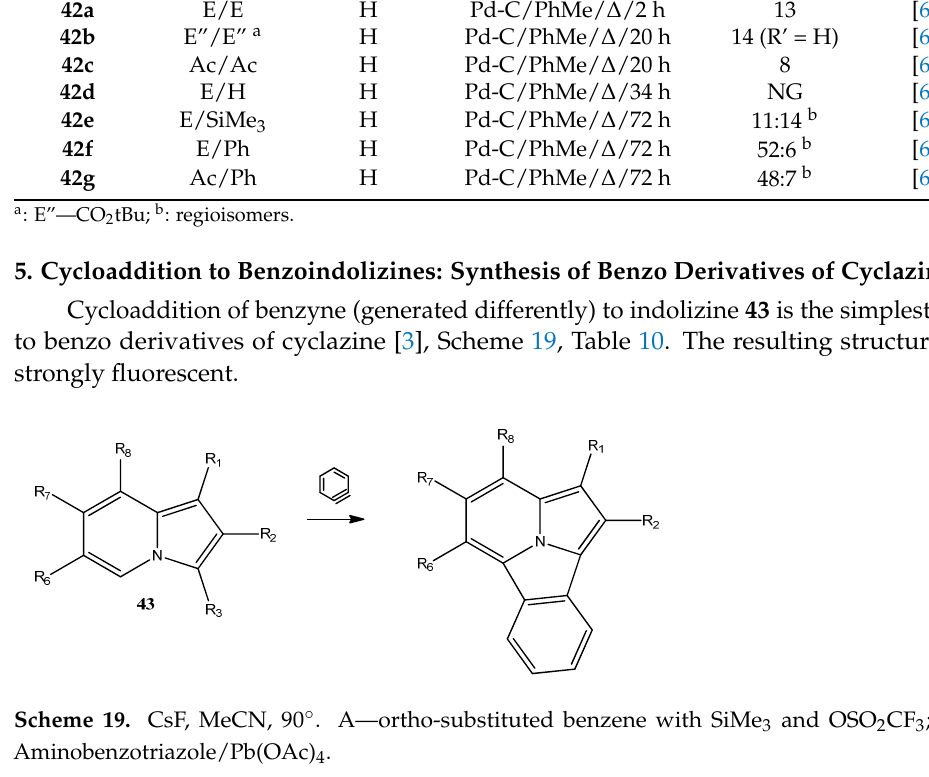
Table 10. Substituents and yields of cycloaddition of benzynes to indolizines (Scheme 19).